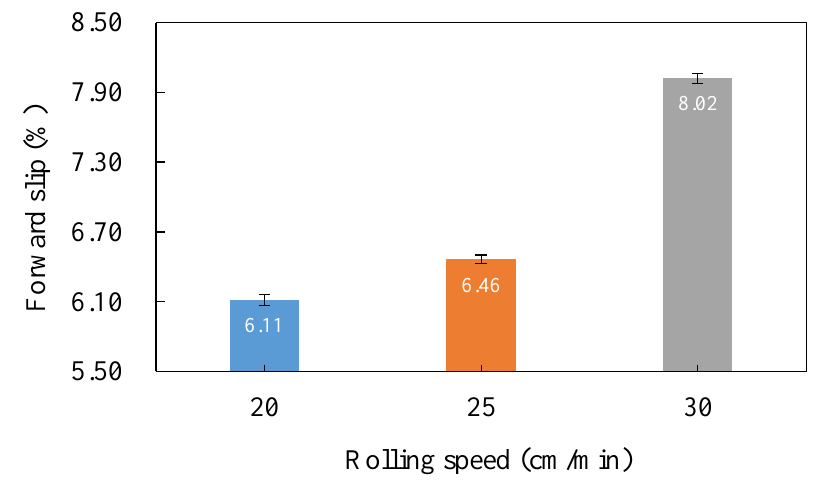
Figure 8. Variation of forward slip with rolling speed for the rolling phase with thicker thickness.